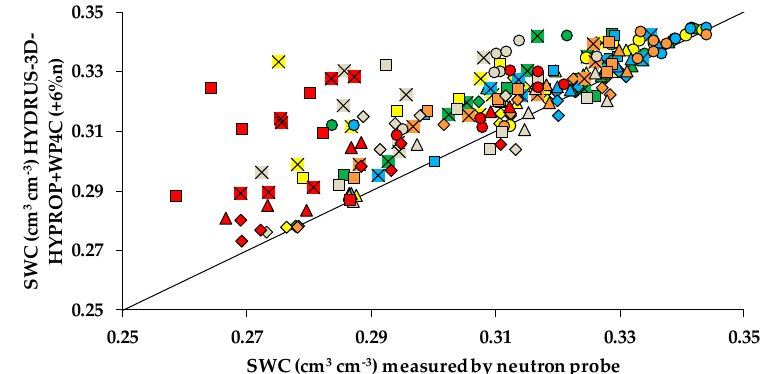
Figure 8. Soil water content ( SWC) simulated with HYDRUS-3D parameterized from HYPROP + WP4, except for n, which was calibrated with the dataset of 2018, versus average measurements by neutron probe on 8 different dates in the 2017 irrigation season. Colors indicate access tubes (green = A, yellow = B, blue = C, orange = D, grey = E and red = F) and shapes indicate depths ( = 40 cm, ∆ = 60 cm, (cid:3) = 80 cm and × = 100 (cid:51)